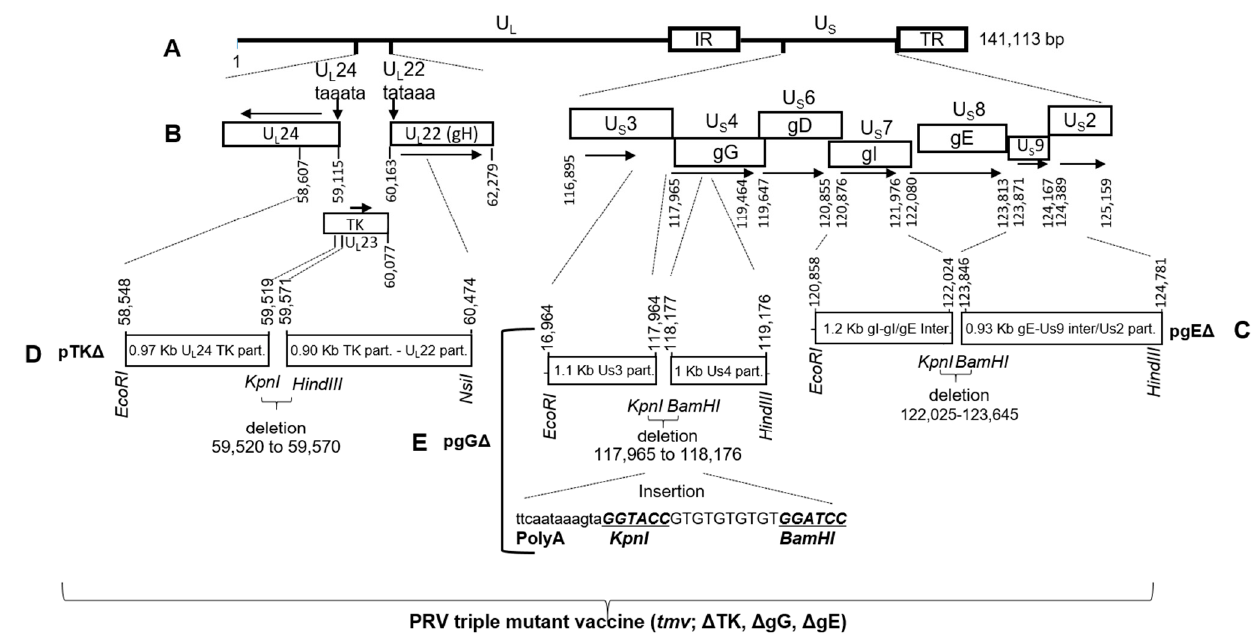
Figure 1. Schematic showing genomic configuration of pseudorabies virus (PRV) and the strategy of thymidine kinase (TK), glycoprotein G (gG), and gE gene deletion to generate a PRV triple mutant virus (tmv) vaccine vector. ( A ) Schematic of PRV wild type (wt) Becker strain backbone [39]. U L —Unique long region; U S —Unique short region; I R —Internal repeat region; T R —Terminal repeat region. Plasmid construct pPRV gE Δ ( C ) was used to introduce gE Δ in the PRV wt backbone ( A ) in the gE locus to generate PRV gE Δ mutant virus. Plasmid construct pPRV TK Δ ( D ) was used to incorporate TK deletion in the PRV gE Δ mutant backbone virus in TK locus ( B ) to generate PRV gE/TK dual gene deleted mutant virus. Finally, PRVtmv (gE/TK/gG ‐ deleted) was constructed by incorporating the plasmid construct pPRV gG Δ ( E ) in to the gG locus in PRV gE/TK dual gene deleted mutant virus backbone. Arrows indicate the direction of the corresponding open reading frame (ORF). Nucleotide numbers correspond to the GenBank accession # JF797219. Part.—partial sequence; Inter.—intergenic sequence.